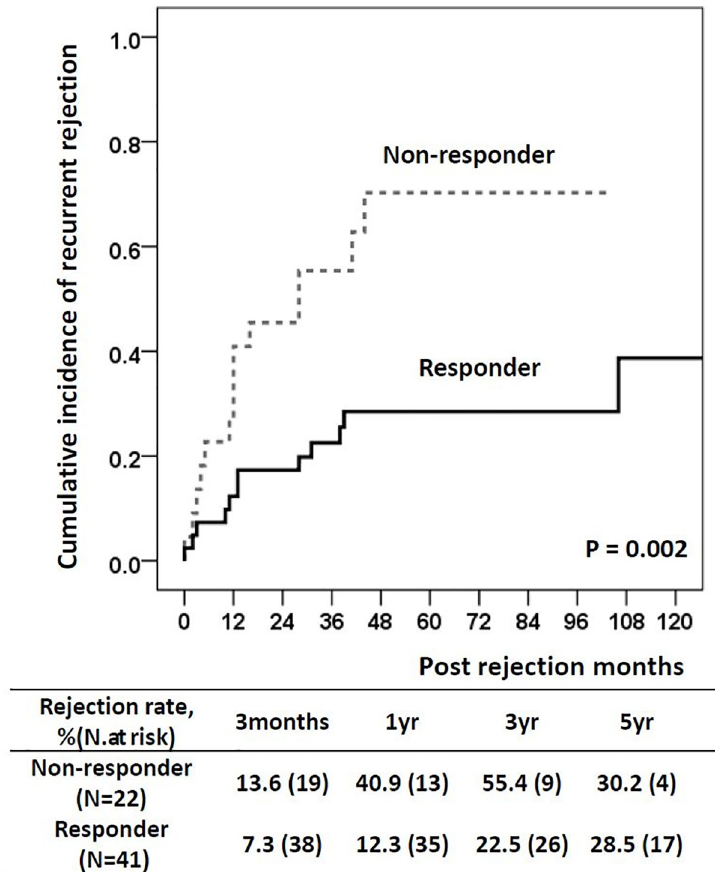
Fig 2. Cumulative incidence of recurrent rejection after rejection